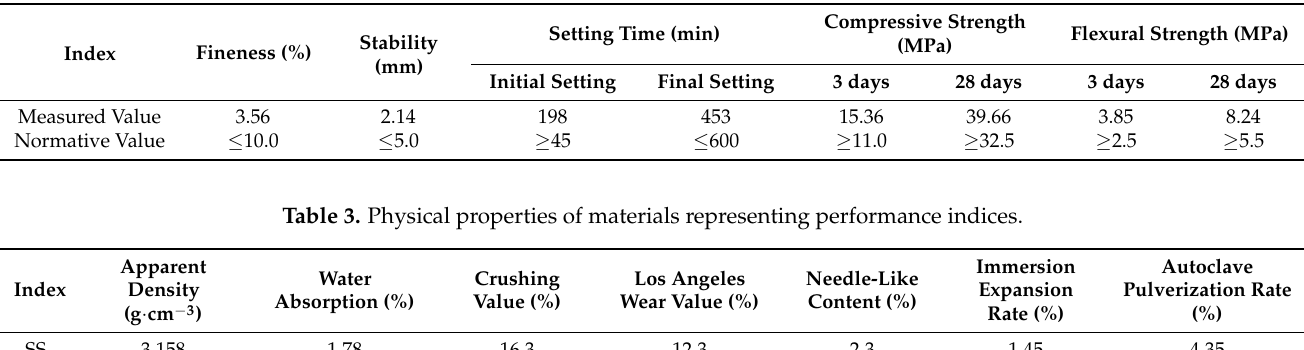
Table 2. Technical indices of the cement.